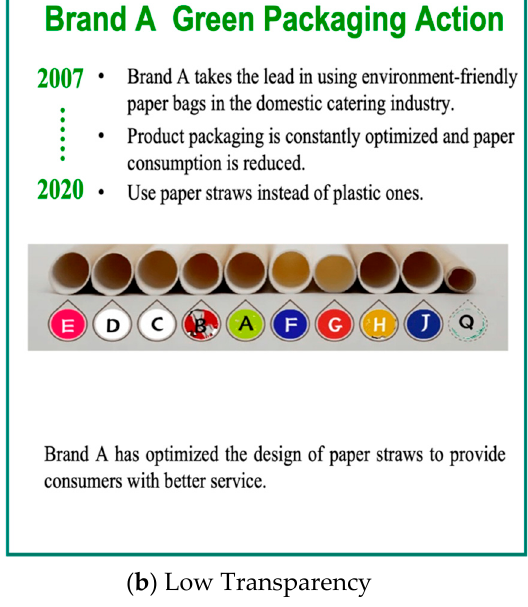
Figure A1. Transparency signaling.